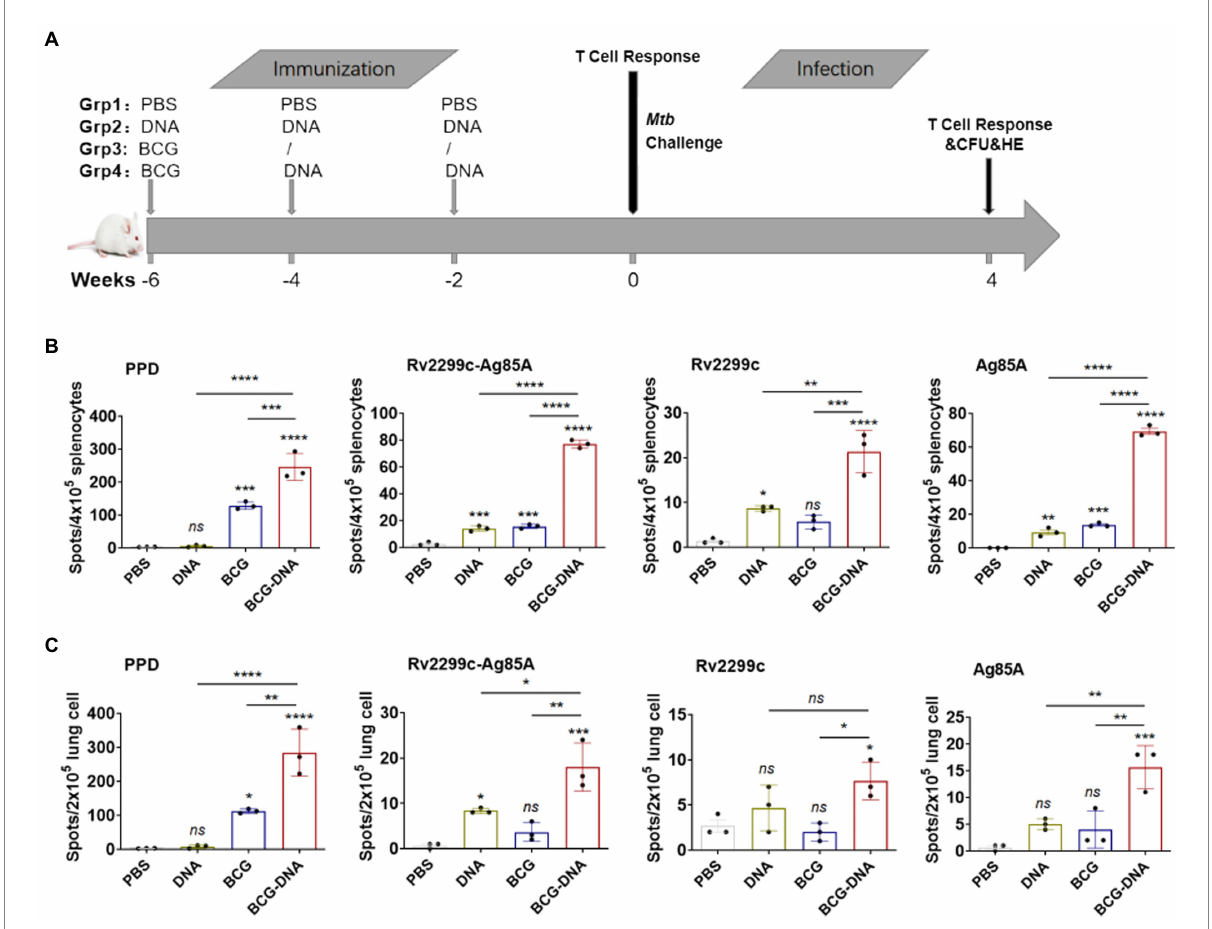
FIGURE 2 ELISPOT assay of antigen-specific IFN- γ -production by T cells from immunized mice prior to infection. (A) Vaccination and infection schedule. At 6 weeks after the primary immunization, cells from spleens (B) or lungs (C) of immunized mice ( n = 3) were isolated and incubated with PPD, Rv2299c, Ag85A or Rv2299c-Ag85A protein for ex vivo IFN- γ ELISPOT assays. Representative responses revealed by Elispot assays and quantified are shown as spot-forming units ( n = 3 mice, one-way ANOVA, mean ± SEM). * p < 0.05, ** p < 0.01, *** p < 0.001, **** p < 0.0001: a significant difference of treatment groups from the appropriate controls (PBS group). ns , no significant